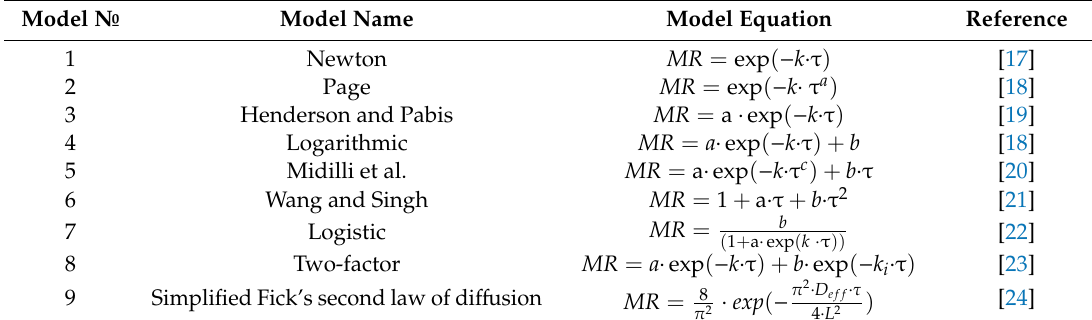
Table 1. The mathematical models used in the